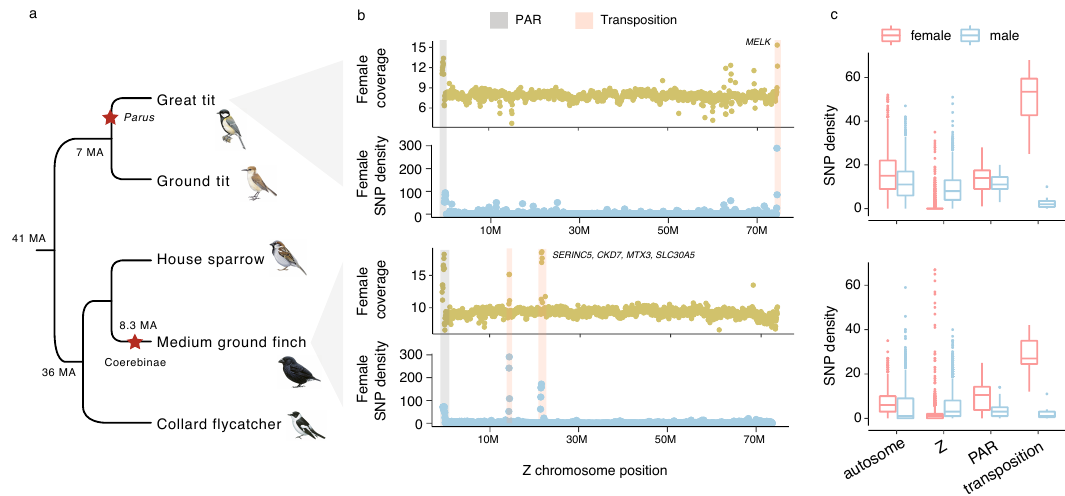
Figure 3. ZTRs identified in another two songbird lineages. ( a ) We detected ZTRs in great tit ( Parus ) and medium ground finch (Coerebinae). The red asterisks denote the origins of ZTRs. ( b ) The ZTR regions are highlighted by the vertical red bars, showing double female coverage and increased female SNP density. The grey bars highlight the PARs which have double female coverage but do not have increased female SNP density. The intact genes in the ZTRs are labelled near the red bars. ( c ) The ZTRs (transpositions) have significantly higher (Wilconxon rank sum test, p < 3.8 × 10 5 ) female SNP density than the rest of the Z chromosome and autosomes, or than the male SNP density, for both species.